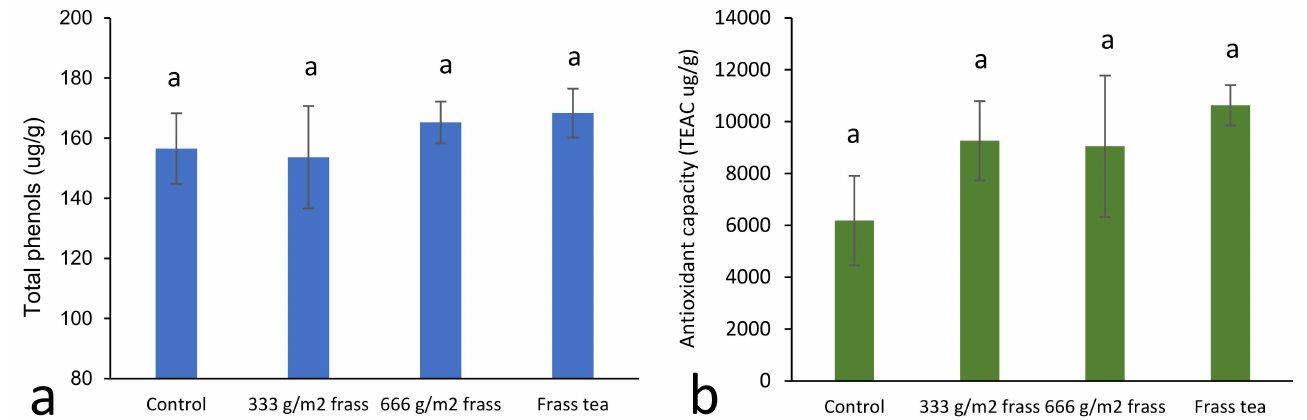
Figure 1. Mean ( ± SE) total phenol ( a ) and antioxidant capacity ( b ) in the leaves of sweetpotato slips three weeks of being grown with black soldier fly ( Hermetia illucens ) larvae frass products or inorganic fertilizer. No significant differences found ( p >